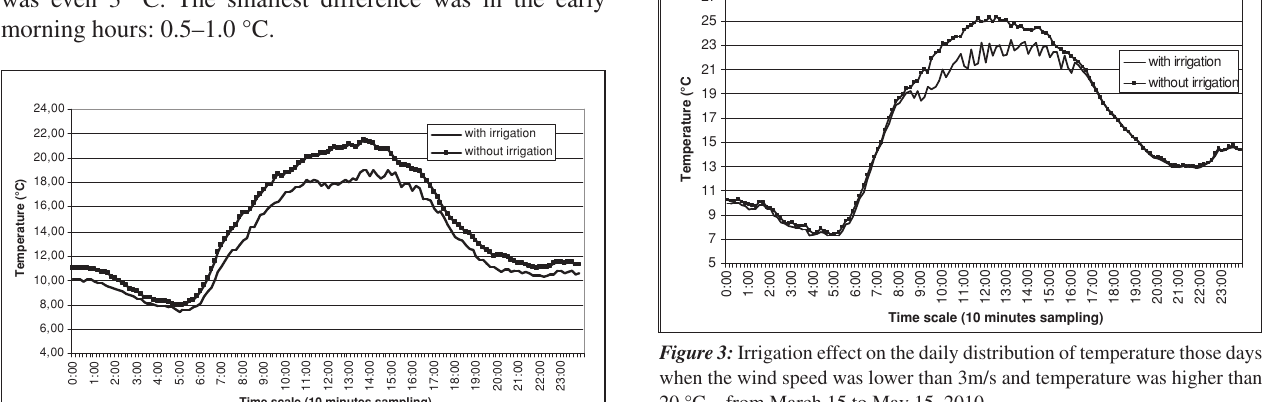
Figure3: Irrigation effect on the daily distribution of temperature those days when the wind speed was lower than 3m/s and temperature was higher than 20 °C – from March 15 to May 15, 2010 .